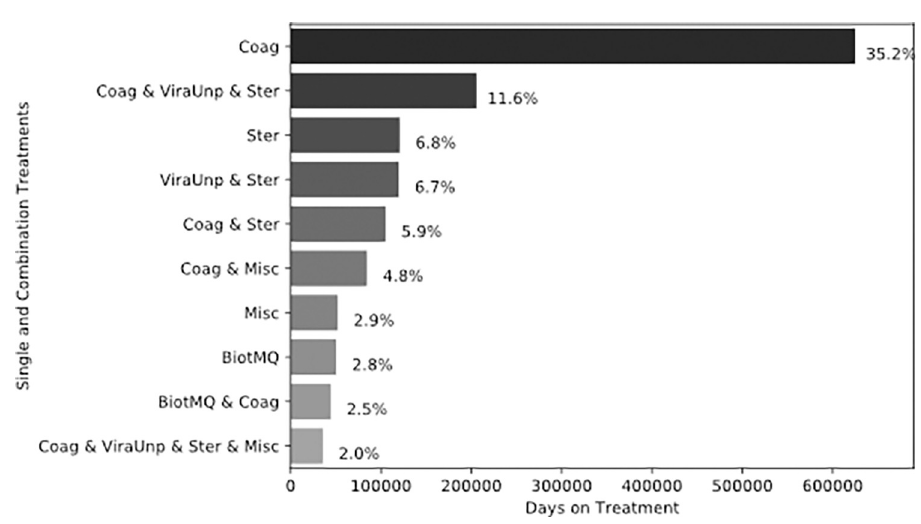
Fig 4. Top 10 treatments based on the number of days prescribed.